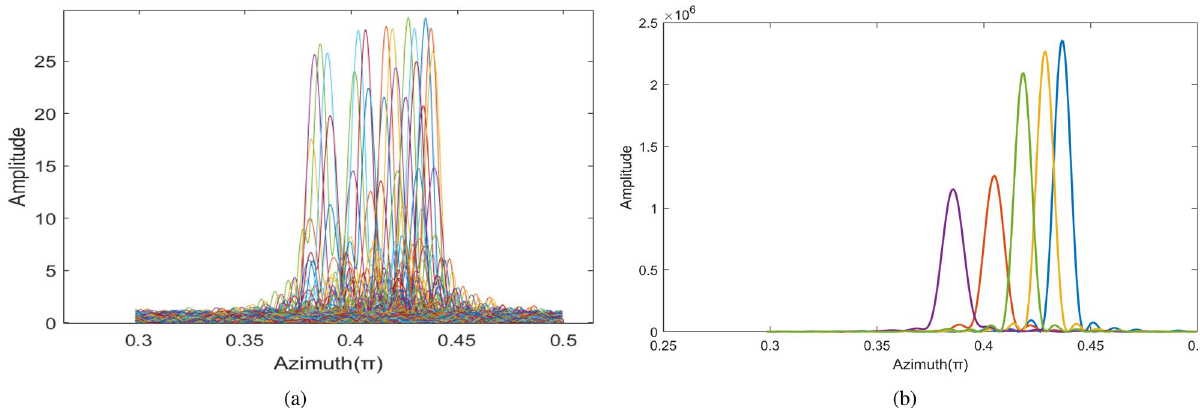
Figure 6. Comparison of azimuth profiles. ( a ) Uncompensated azimuth profile. ( b ) Azimuth profile after